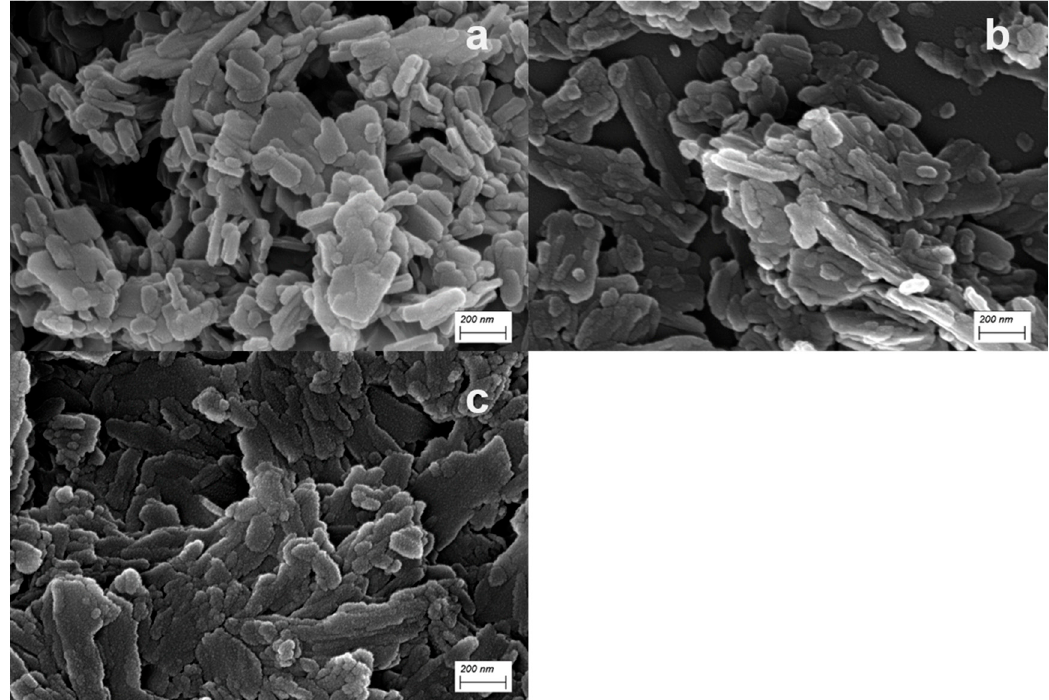
Figure 7. SEM micrographs of PR 146 obtained from: ( a ) miniemulsion, ( b ) macroemulsion, and ( c ) bulk solution.